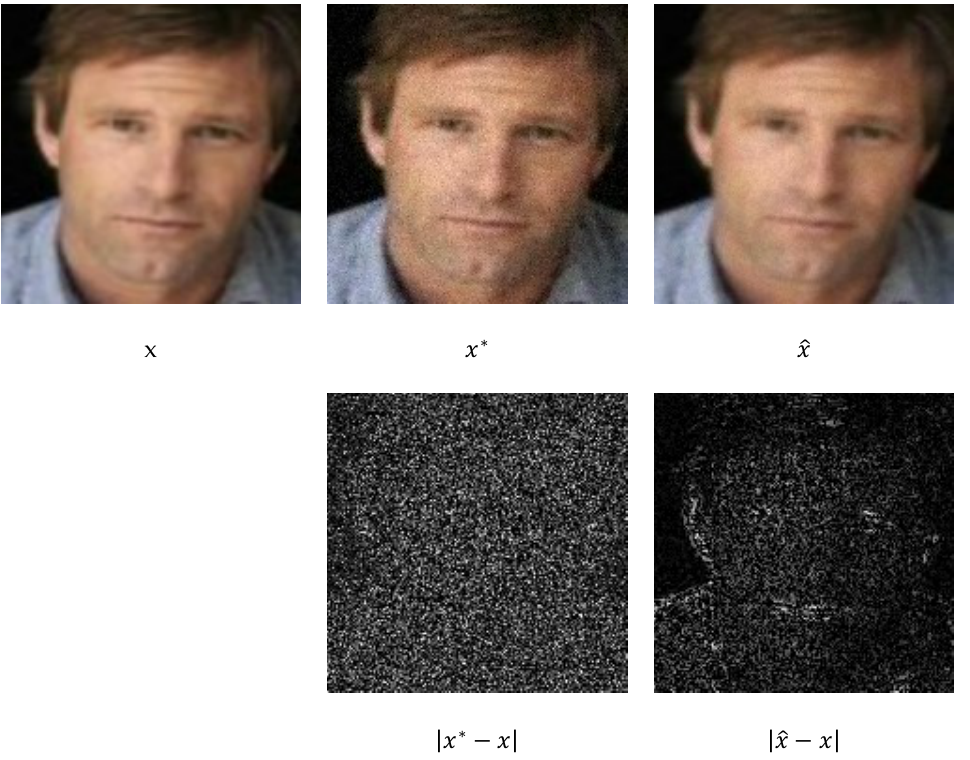
Figure 6. Denoising results with UDNN. x represents the clean image, x ∗ represents the attack image and ˆ x represents the denoised image. The images below them are the difference images between the images to the clean image.